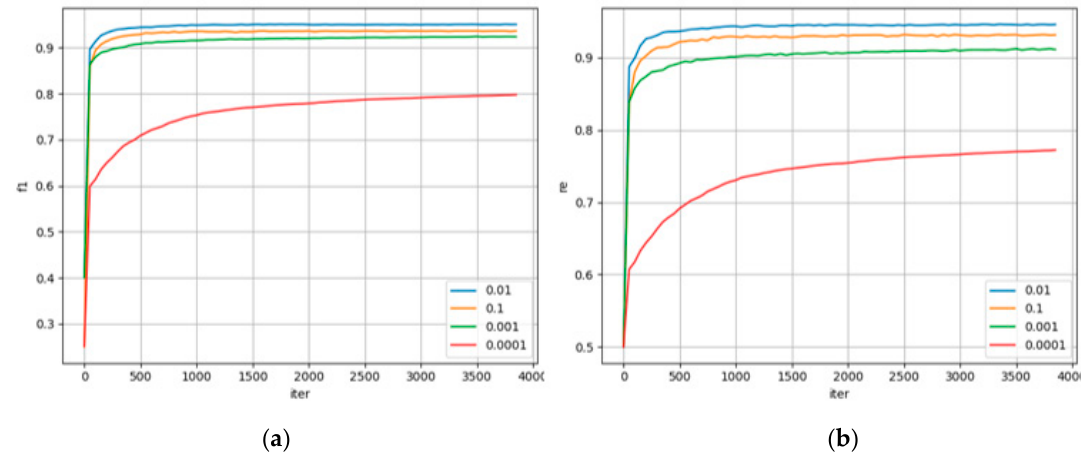
Figure 5. ( a ) F1 score at different learning rates on the training set. ( b ) Recall at different learning rates on the training set.